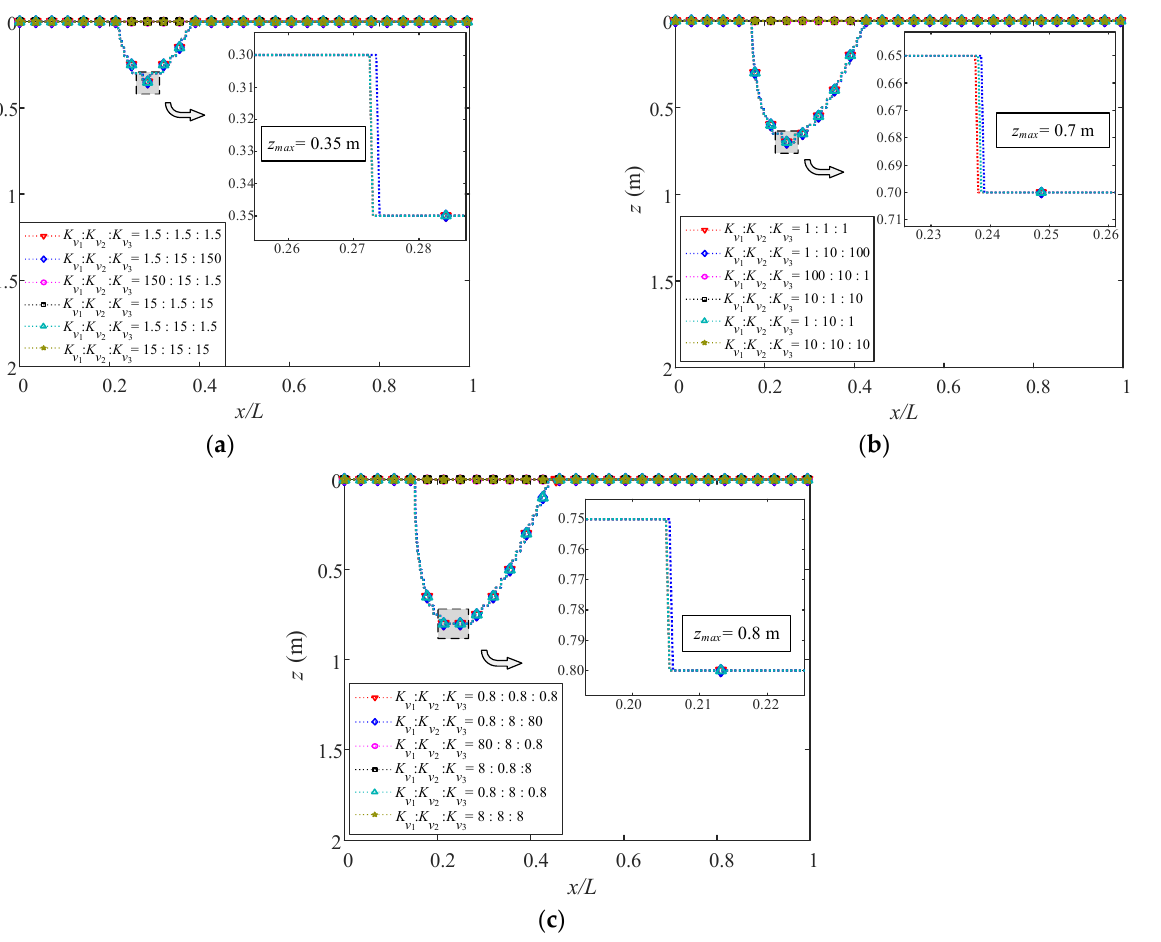
Figure 16. Liquefaction depth along wave propagation at t = 20 s with ( a ) K vo / K ho = 1.5, ( b ) K vo / K ho = 1 (isotropic case), and ( c ) K vo / K ho = 0.8 ( o = 1,2,3).